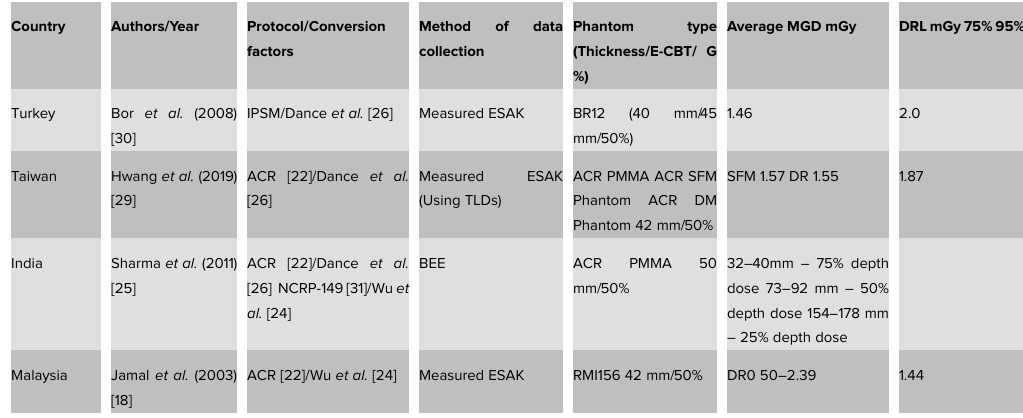
Table 1: Summary of the studies related to Phantom-based